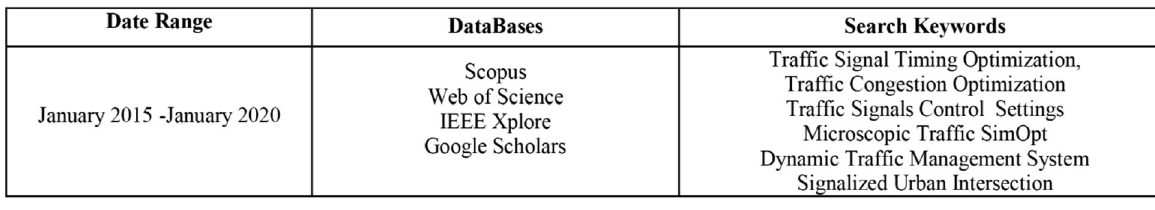
Table 1 Search parameters of the literature review